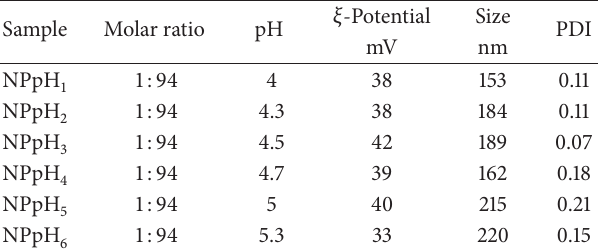
Table 2: 𝜉 -Potential and size, effect of